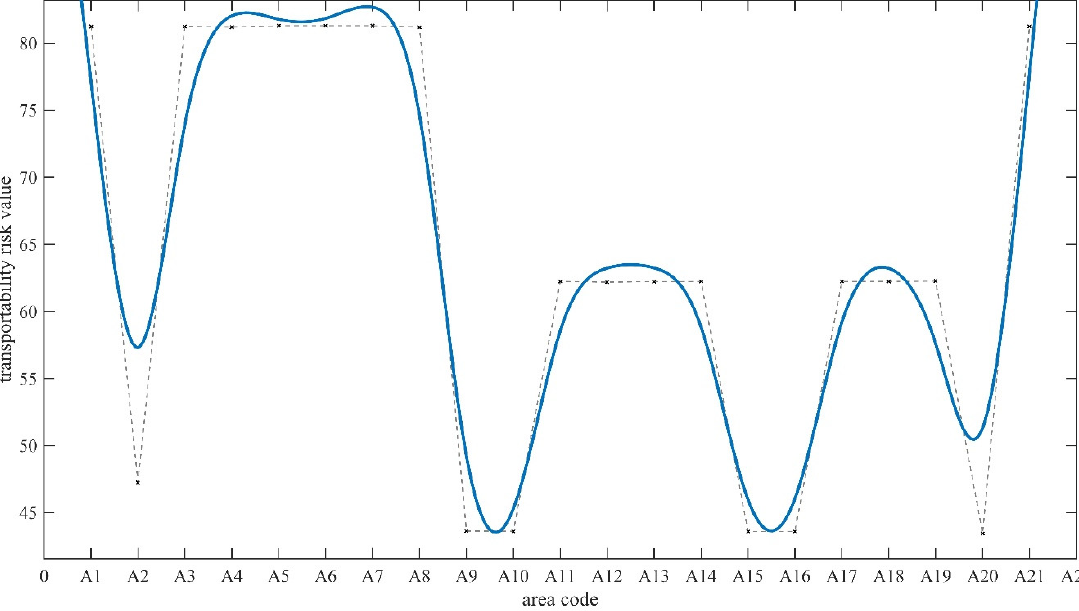
Figure 10. Change trend of transportability risk values for fireworks carried on Ship X. (Note: A1-A22 represent Chang-